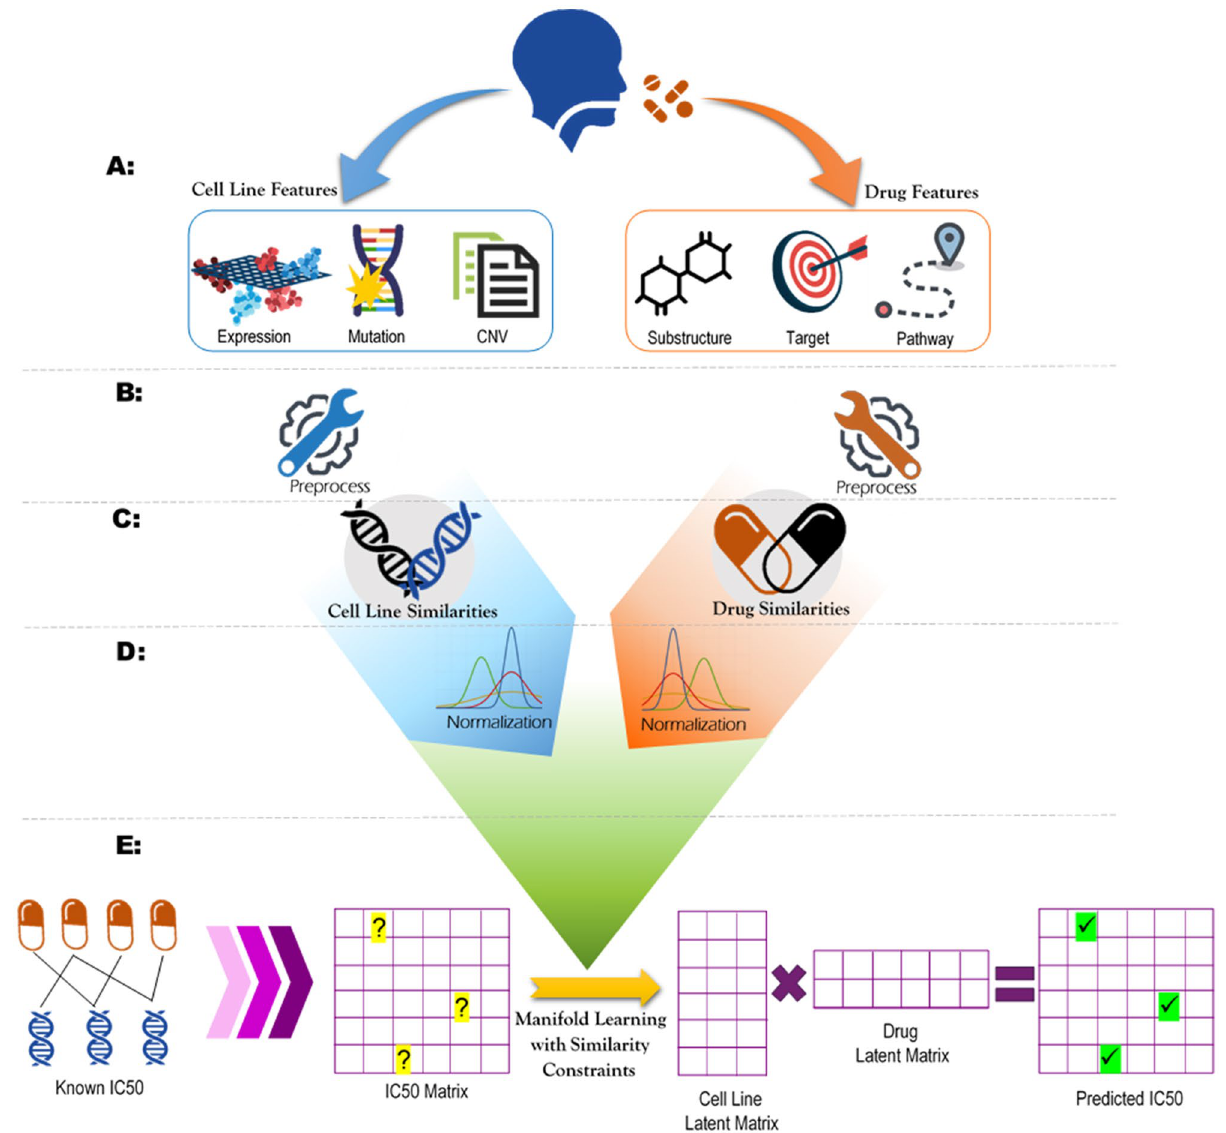
Figure 8. The overall workflow of ADRML. ( A ) Collecting various types of cell lines and drugs features. Further steps can be executed for each pair of cell line feature types and drug feature types. ( B ) Pre-processing the collected feature by removing the features with missing data for more than half samples and then imputing the remaining missing values. ( C ) Computing various types of cell line similarities and drug similarities using similarity functions. ( D ) Normalizing the similarity matrices using symmetric normalized Laplacian. ( E ) The IC50 matrix constructed from known IC50 values is factorized into two low-rank latent matrices with constraints of the similarity matrices. The unknown IC50 values can be predicted by multiplying the latent Pre-processing to impute the missing data. Several steps were done to impute the missing data. First, the features that were missed in the majority of cell lines are removed. Second, the cell lines that contain missing values for more than half of the features were excluded. The other missing values were imputed using a k-nearest neighbor approach. To this aim, the distance measure between cell lines was defined as the Euclidean distance of their expression profiles because there is no missing in expression features of the cell line; thus, the distance can be calculated for each pair of cell lines. The distance between c 1 , c 2 is D ( c 1 , c 2 ) = || EXPR c the mean feature value among 10-nearest cell lines was used to impute the missing IC 50 value of drug d or CNV value of gene g in cell line c .